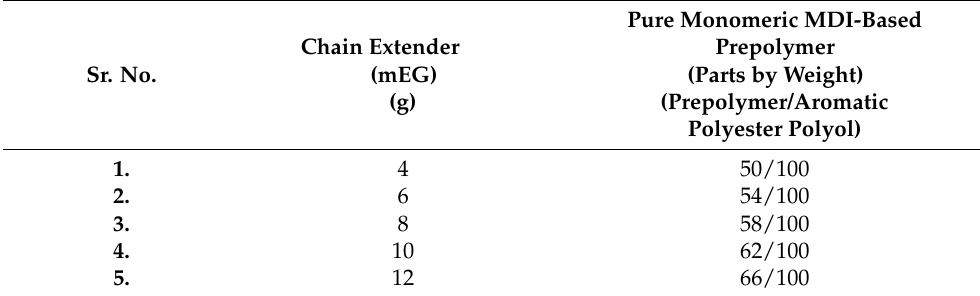
Table 3. Amount of pure monomeric MDI-based prepolymer used for preparing polyurethane w.r.t different concentrations of chain extender